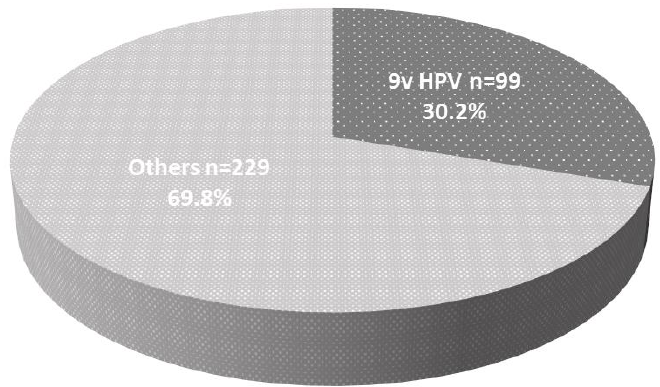
Figure 1. The detection rate of 9v human papilloma virus (HPV) among Japanese male sampling: Of 328 genotypes, 30.2% (99/328) were covered by the 9v HPV vaccine.